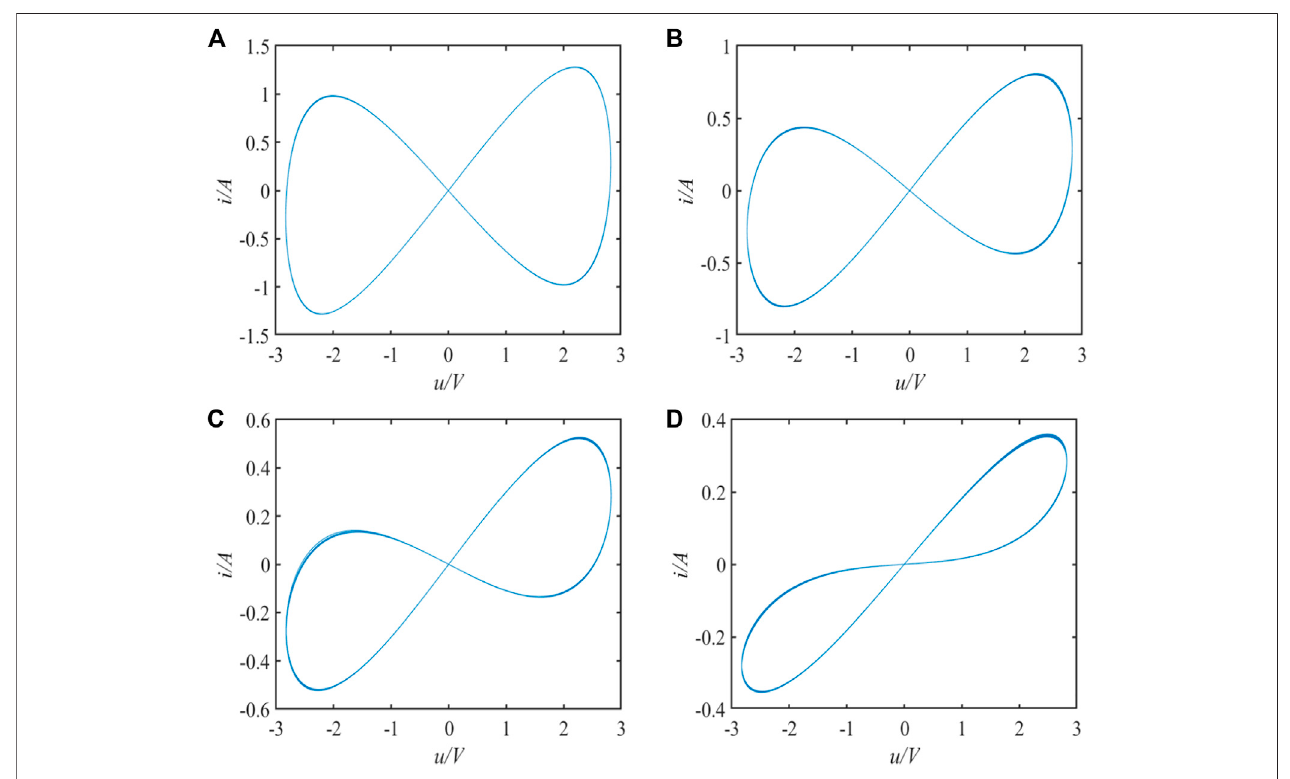
FIGURE 1 | The u – i curve of memristor: (A) f = 0.5 kHz with u = 3 V, (B) f = 1 kHz with u = 3 V, (C) f = 2 kHz with u = 3 V, (D) f = 5 kHz with u = 3 V.